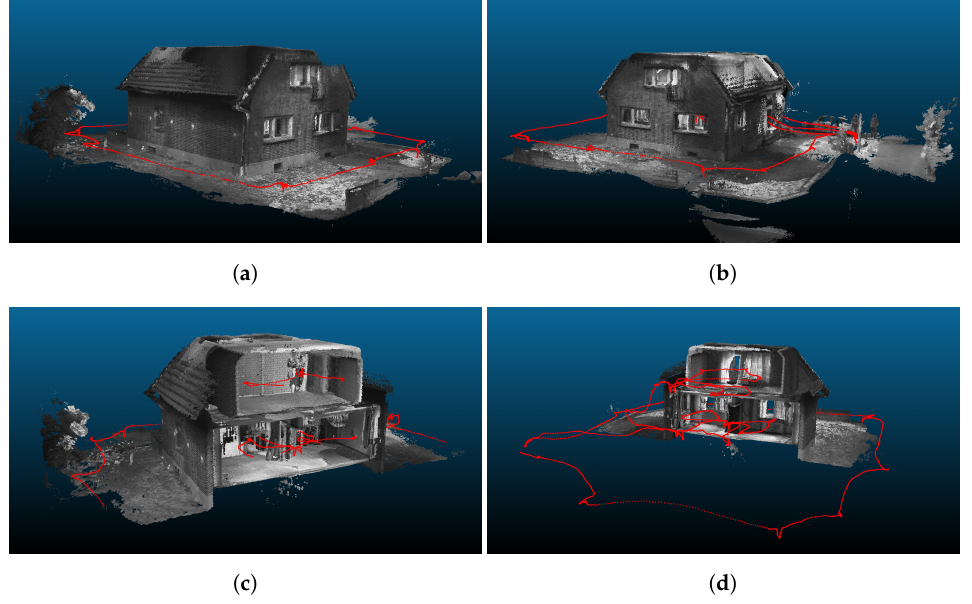
Figure 6. Multiple views of the point cloud generated from the IPS trajectory (red dots) and the IPS stereo images. ( a , b ) Building exterior views. ( c , d ) Interior view showing the two